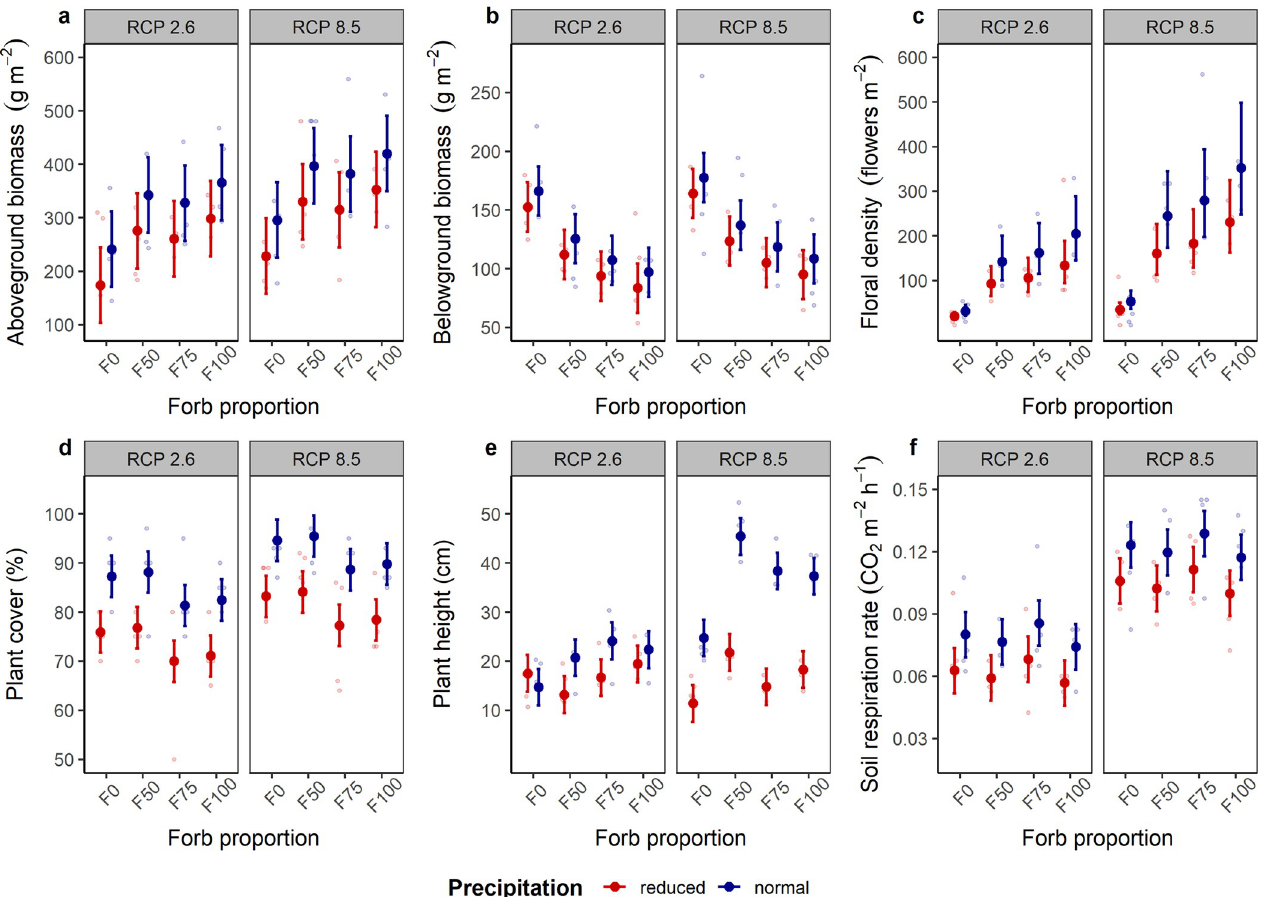
Fig 2. Effects of forb proportion, precipitation, and climate change scenarios on indicators of grassland functioning. (a) Aboveground biomass, (b) belowground biomass, (c) floral abundance, (d) vegetation height, (e) cover, and (f) soil respiration rate (means ± 95% confidence intervals) of mesocosm communities in the climate chambers of an ecotron facility. Data points are light-colored circles (n = 4).